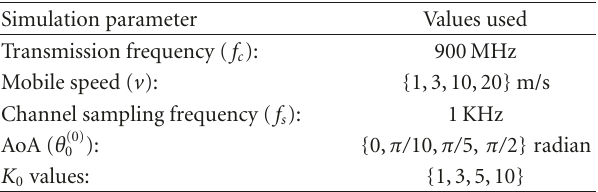
Table 1: General parameter set for the simulations. Simulation parameter Values